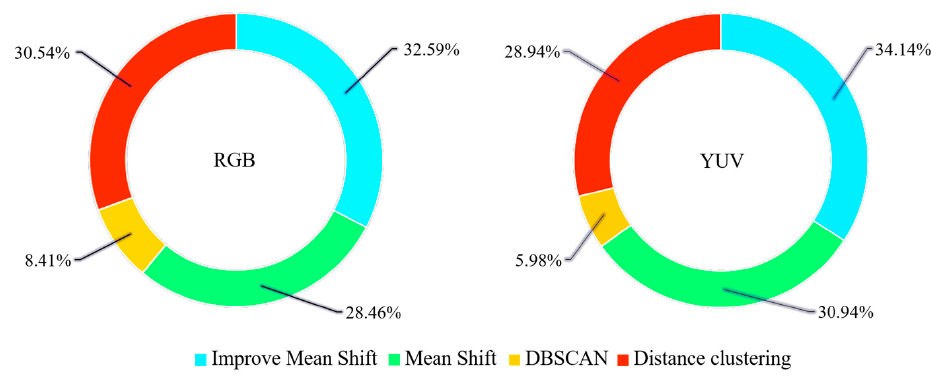
Figure 10. Detection results of the four clustering algorithms in the RGB and YUV color spaces.